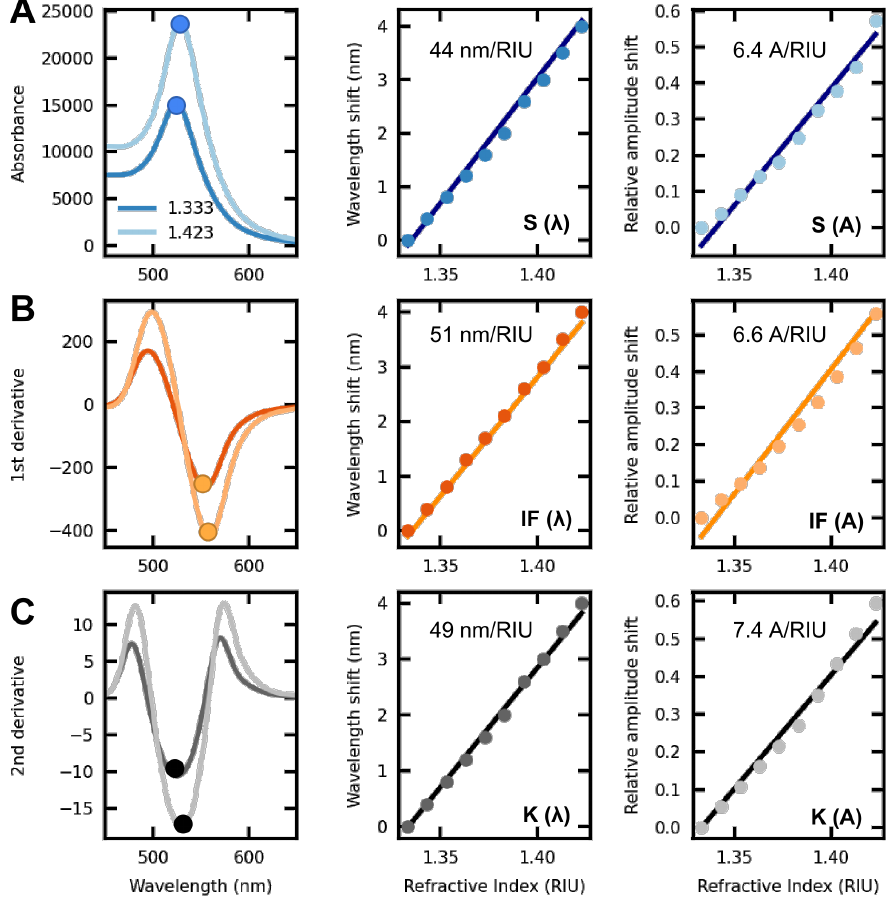
Figure 2. Scheme of the common optical response of a plasmonic nanostructure when subjected to external RI variations; ( A ) LSPR band (left) along S( λ ) and S(A) shifts; ( B ) First derivative (left) along IF( λ ) and IF(A) shifts; ( C ) second derivative (left) along K( λ ) and K(A)